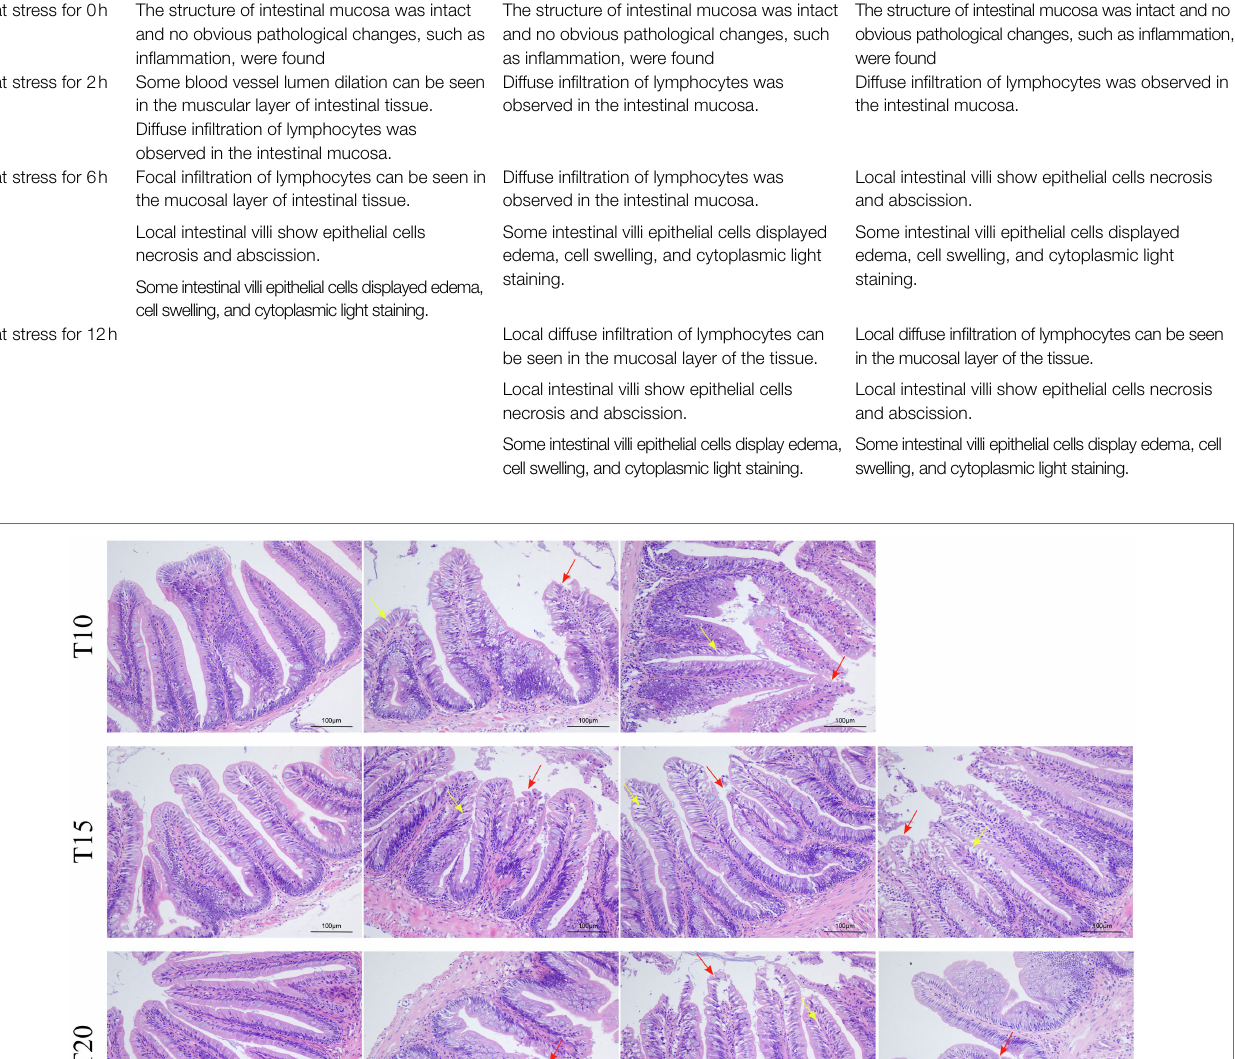
TABLE 2 | Intestinal histological variation of heat stressed O. stewarti juvenile with different acclimation histories. Acclimation temperature ( °